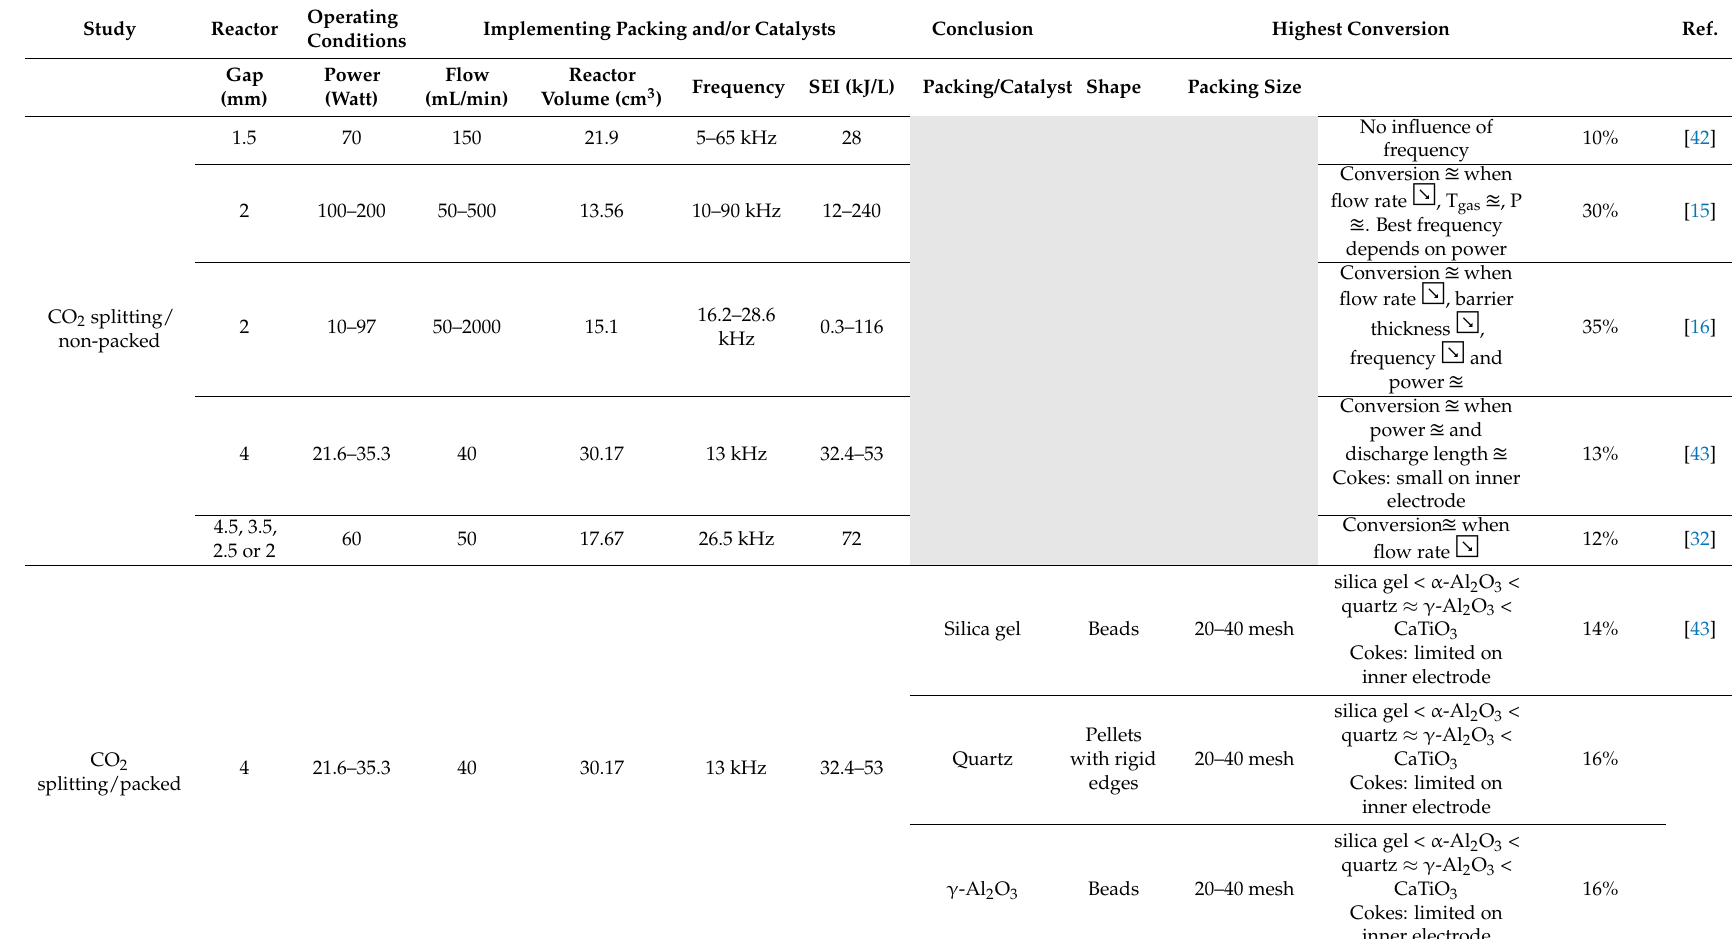
Table 1. Summary of a selection of literature for CO 2 splitting in a non-packed and a packed DBD reactor.